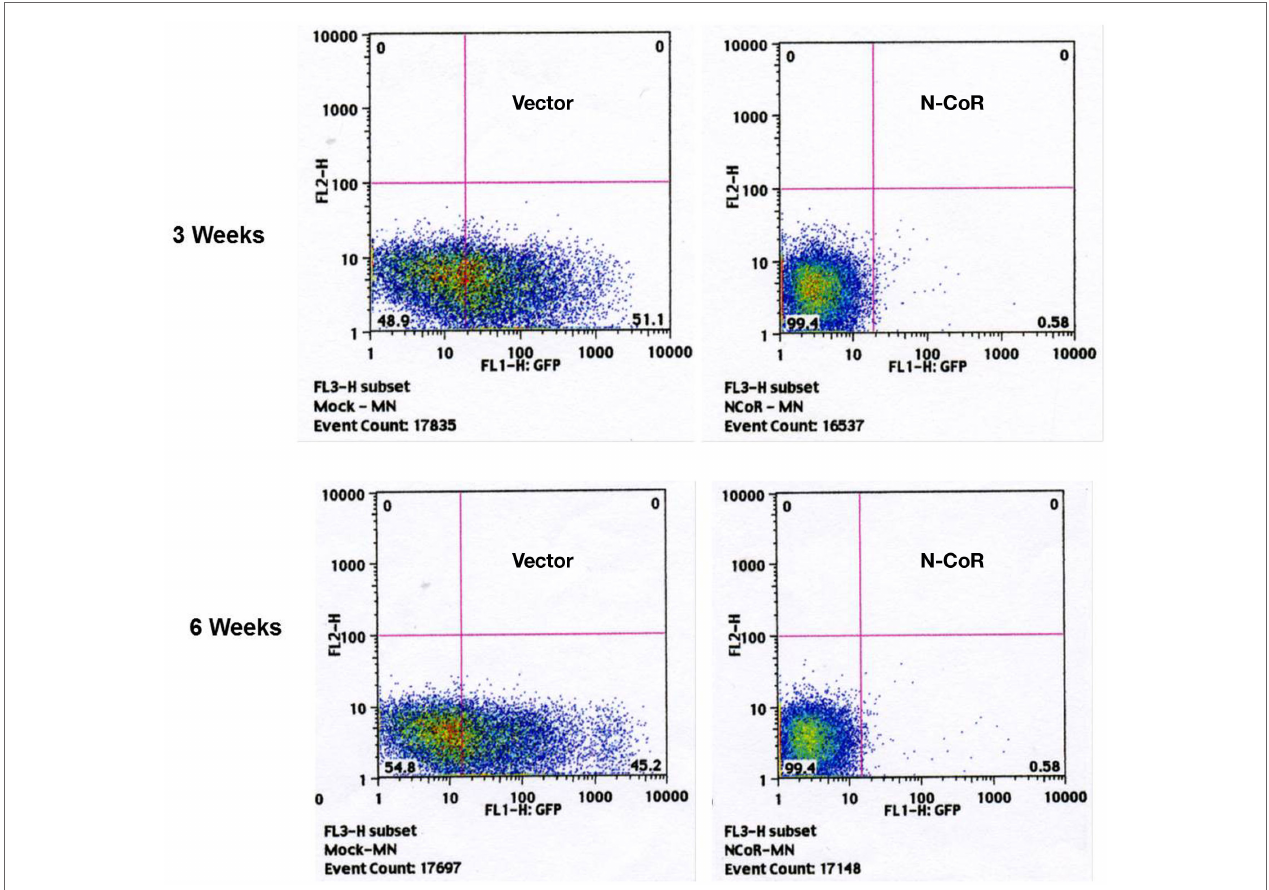
FigUre 3 | ectopically expressed n-cor inhibits the growth and repopulating potential of c-Kit + stem cell/progenitor cells in vivo . 5 × 10 5 N-CoR or control vector-transfected BM cells were transplanted intravenously into sublethally irradiated C57BL/6 mice (8 Gy). The percentage of GFP-positive cells in the peripheral blood of transplanted mice was determined by FACS at the intervals of weeks 3 (upper panel) and 6 (lower